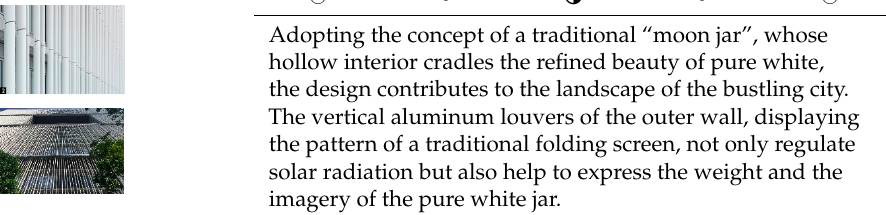
Table 3. Structural facades: Urban Hive (Archium 2008).